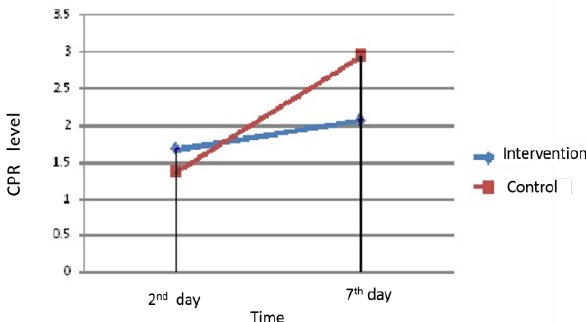
Figure 2. CRP level in study